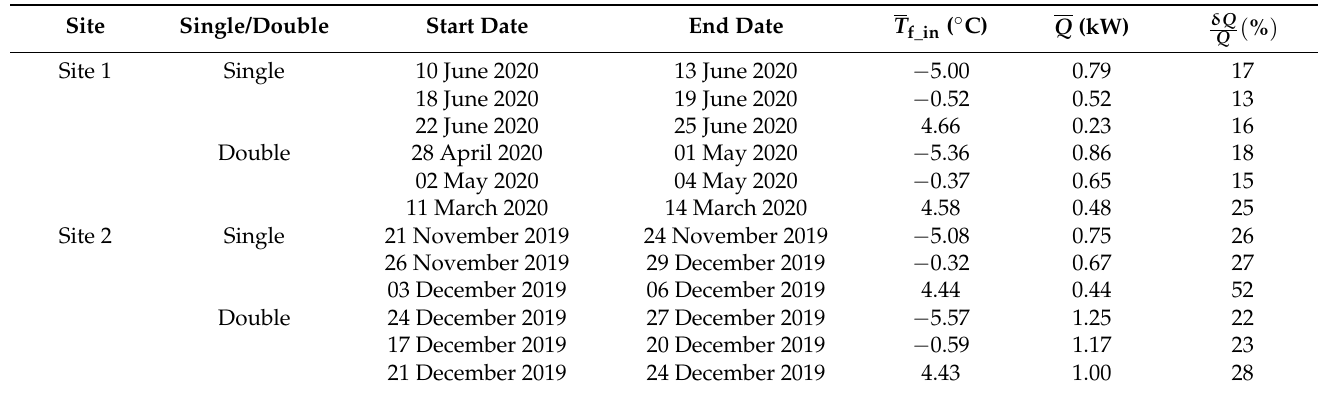
Table 1. A summary of the experiment configurations and